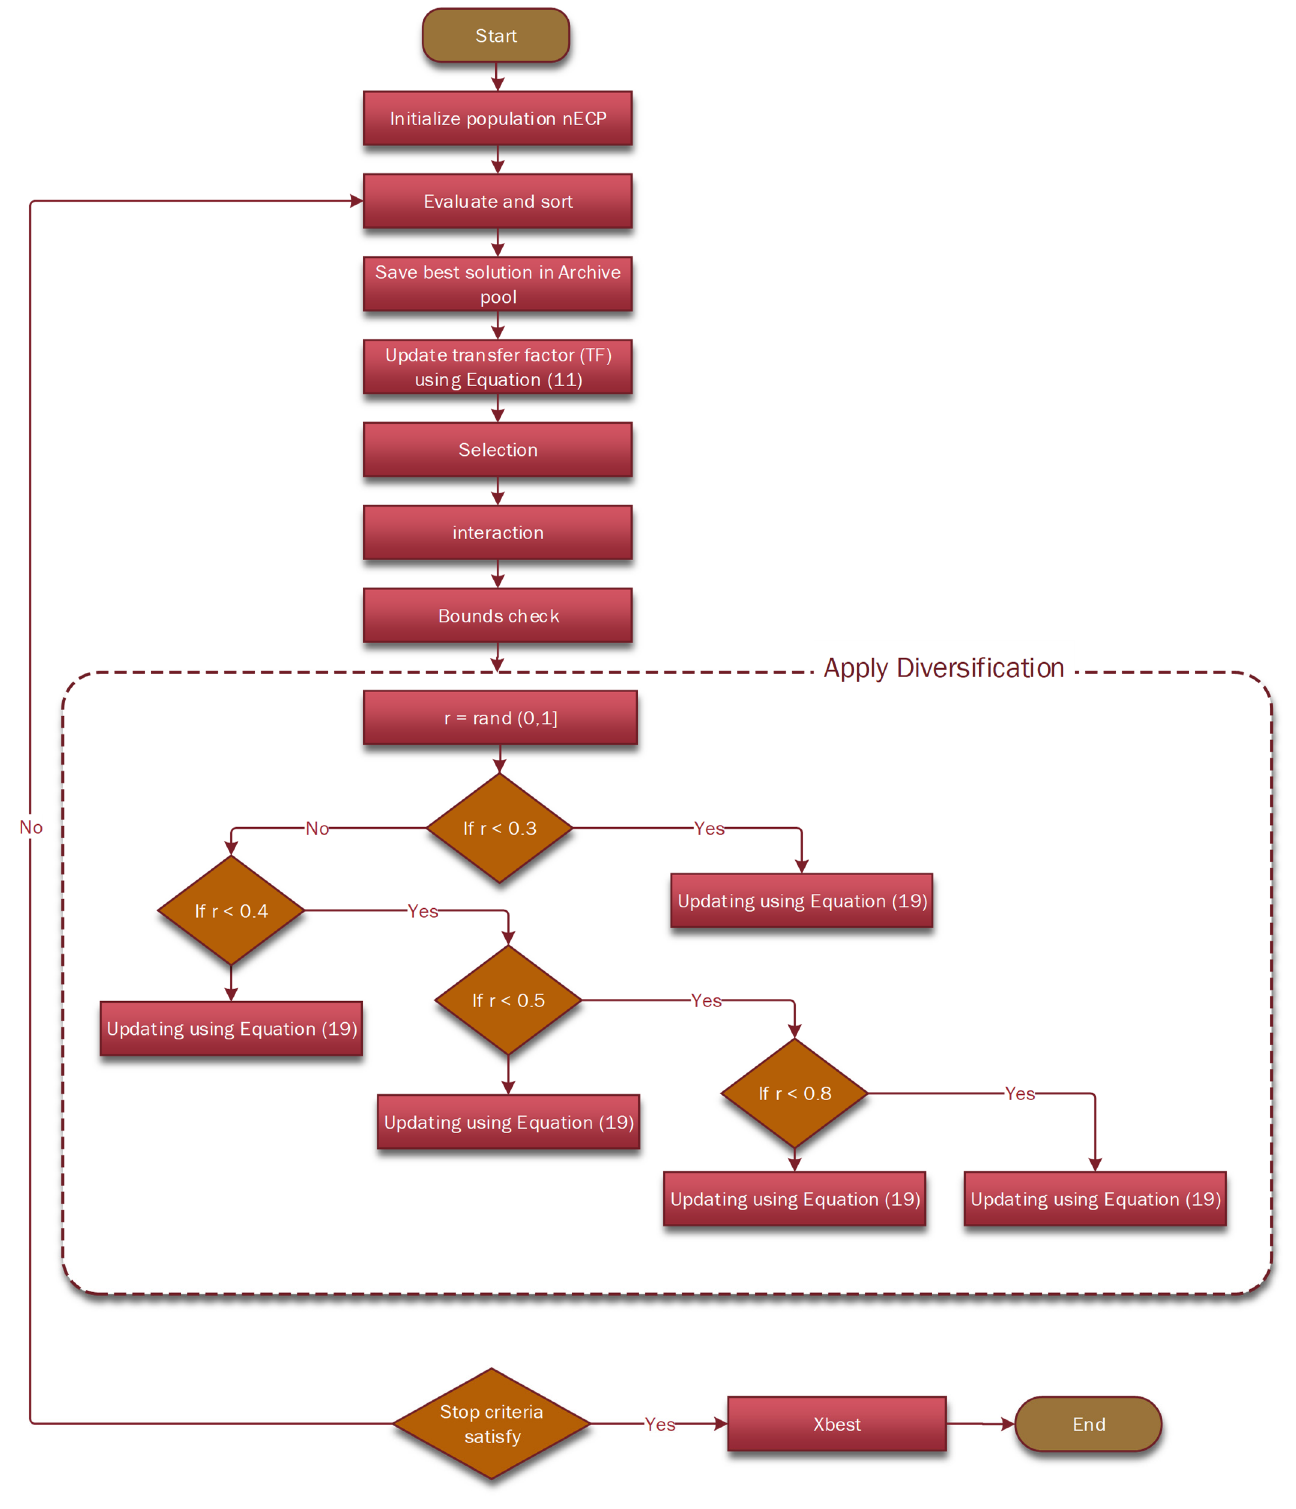
Figure 4. Flowchart of MECPO method.